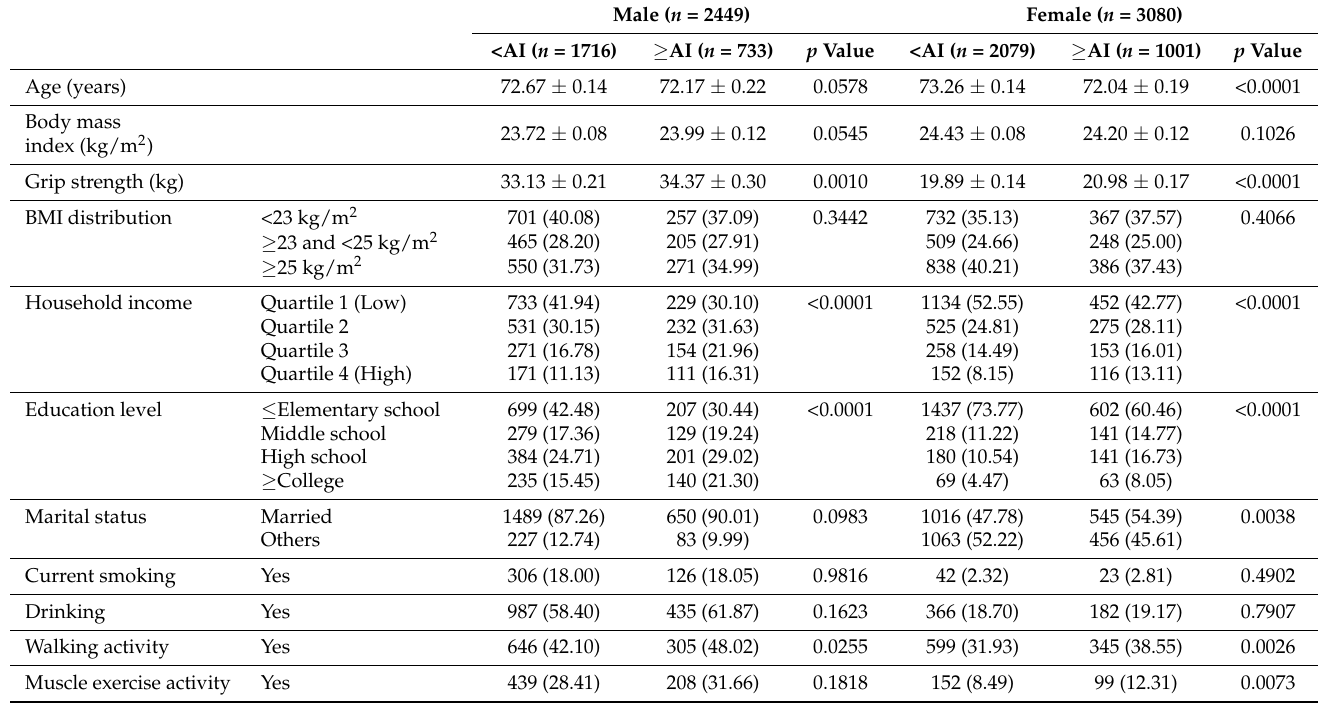
Table 1. General characteristics of the study subjects according to EPA and DHA